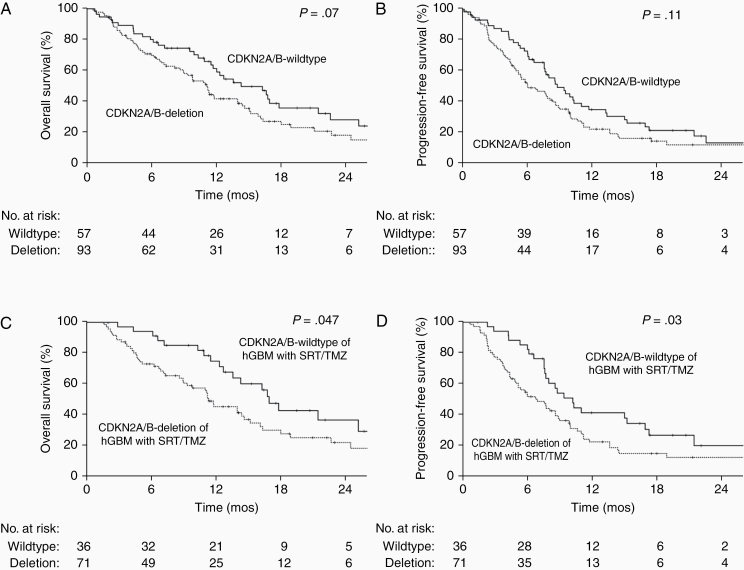
Survival outcomes of patients stratified by CDKN2A/B deletion status. (A) Overall survival (OS) of the entire study cohort. (B) Progression-free survival (PFS) of the entire study cohort. (C) OS of the subset receiving standard-course radiation therapy (SRT) and temozolomide (TMZ). (D) PFS of the subset receiving SRT and TMZ.